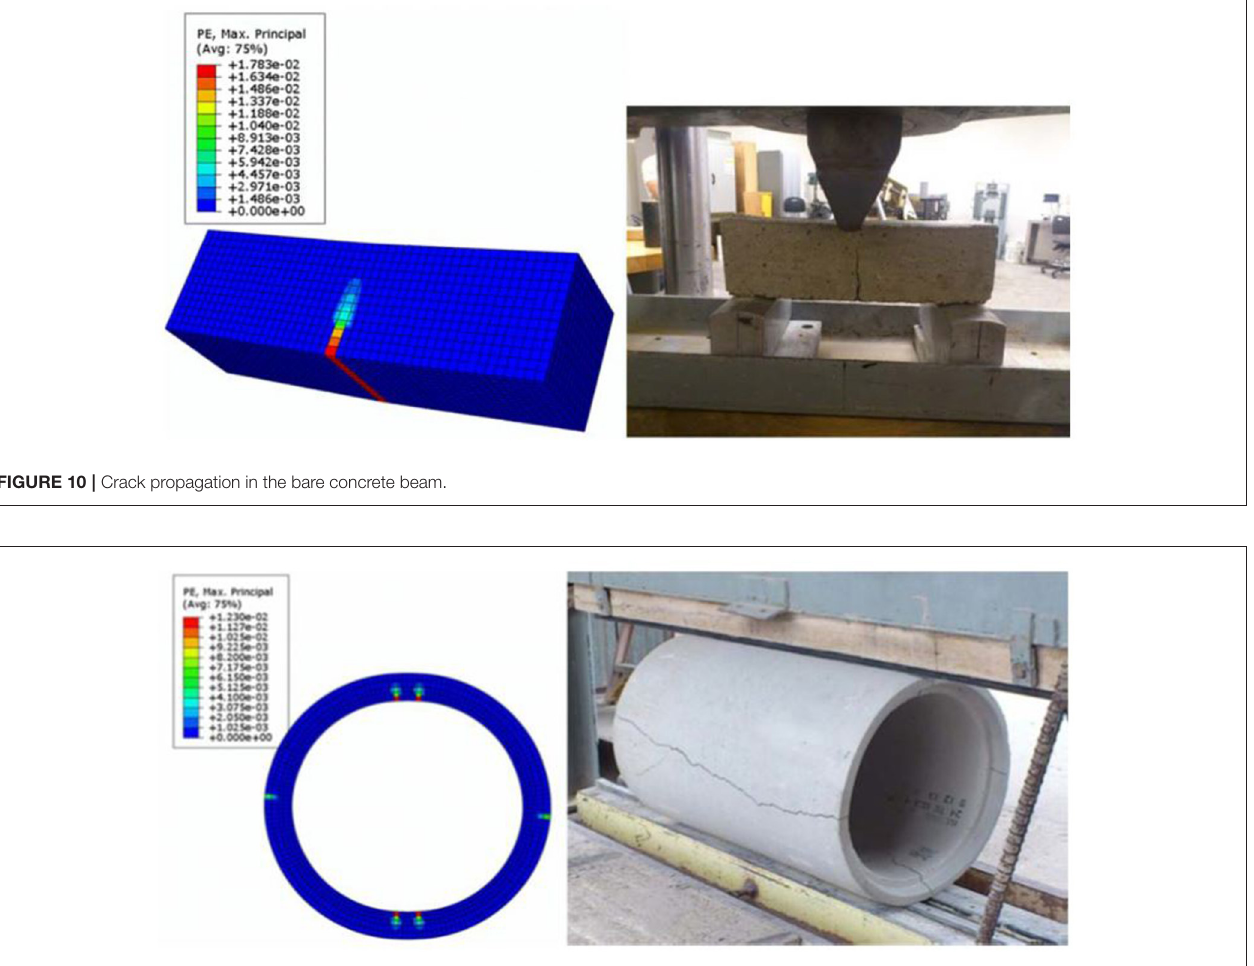
FIGURE 11 | Crack propagation in bare concrete